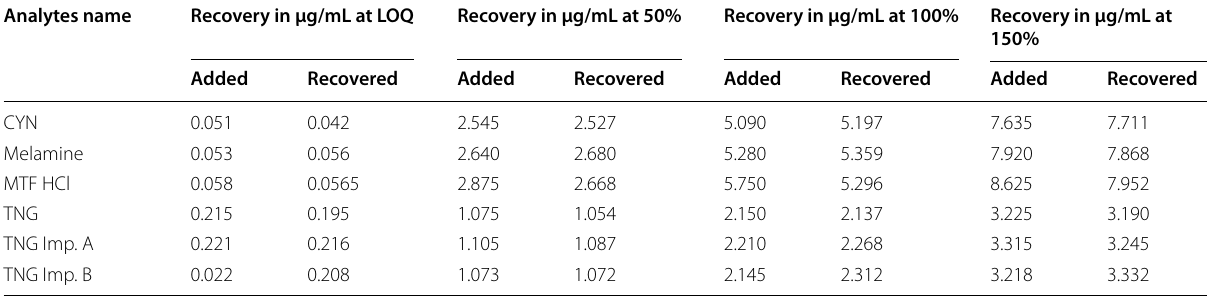
Table 4 Recovery study results in µg/mL